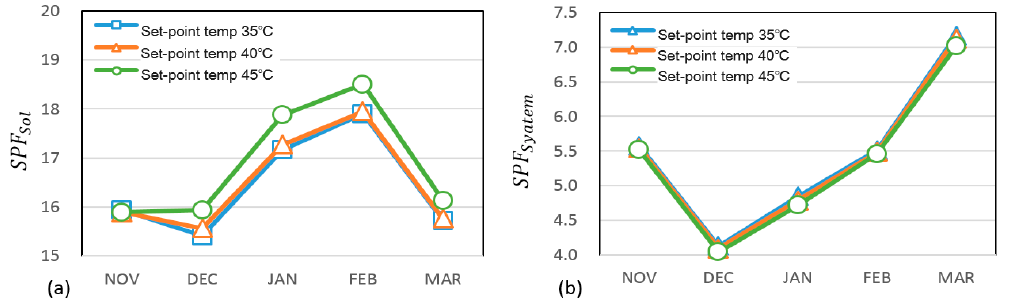
Figure 33. The SPF of total system according to the set-point temperature of PVT. ( a ) PVT; ( b ) total systems.